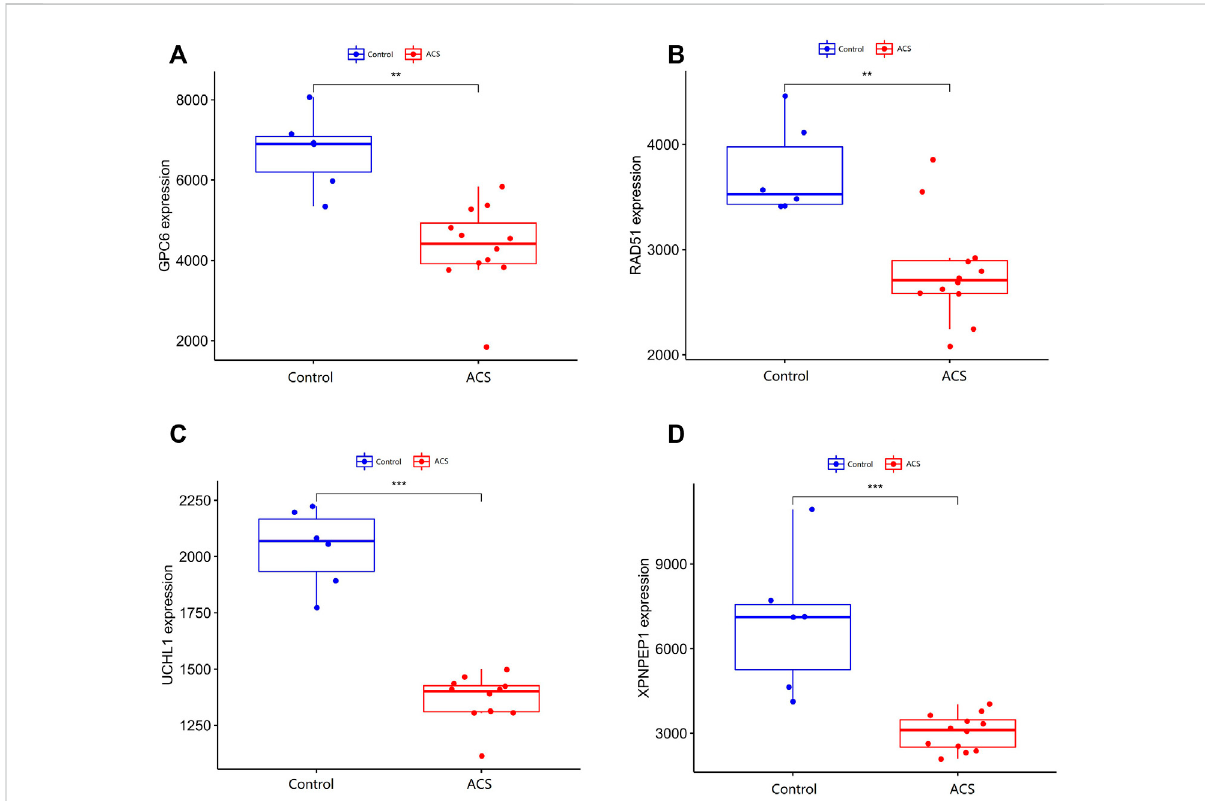
FIGURE 8 Validation of differentially expressed genes in ACS. (A – D) shows the expression of differentially expressed genes in the GSE95368 data set in ACS and non-ACS patients. The red box represents gene expression in the ACS group, and the bule box represents gene expression in the